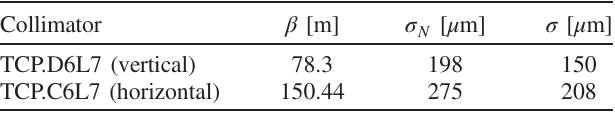
TABLE II. Lattice β functions and 6.5 TeV beam sizes in the collimation plane, with the nominal emittance of ε N ¼ 3 . 5 μ m ( σ N ) and the measured emittance of ε ¼ 2 . 0 μ m ( σ ), at the primary collimators in IR7. Values listed are for beam 1.